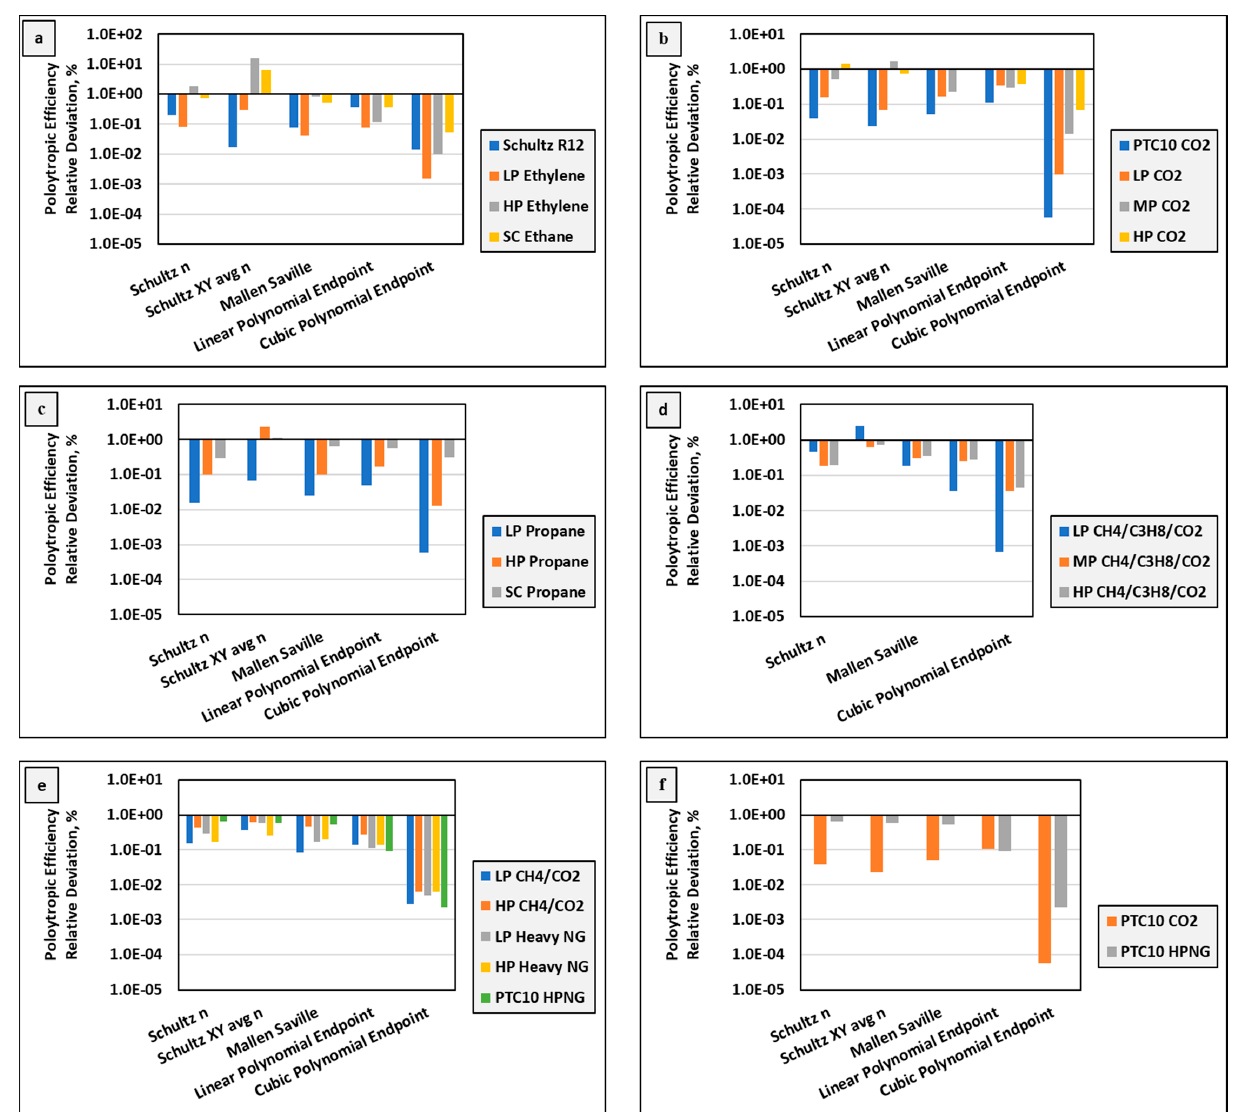
Figure A1. ( a – f ) Summary comparison of relative deviation results for endpoint methods.